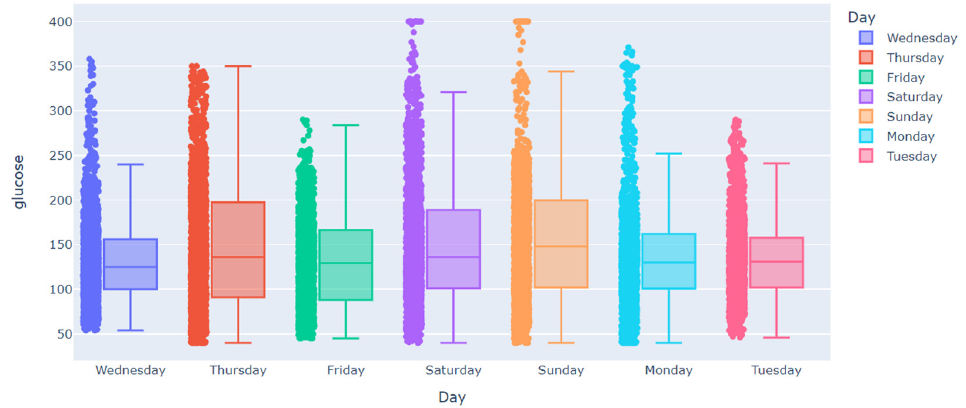
Figure 1. Boxplots of CGM by day of the week for the training data of the subject 584. In Figure 2, boxplots of the CGM by day of the week for subject 575 ′ s training dataset show no cyclic pattern.